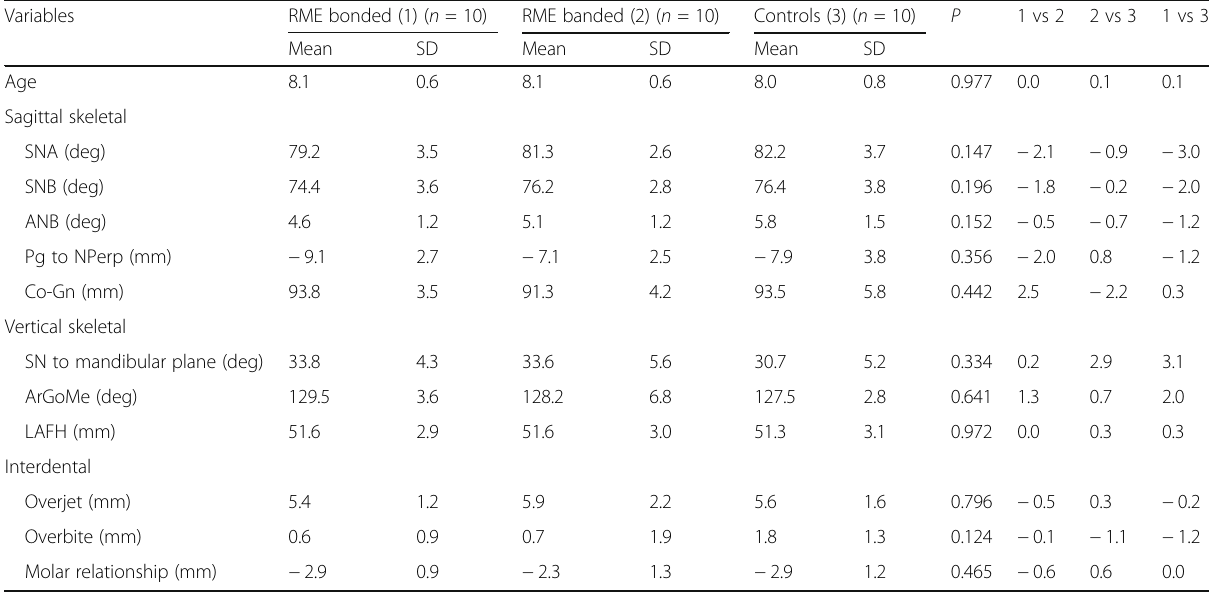
Table 1 Descriptive statistics and statistical comparisons of starting forms (ANOVA with Tukey ’ s post hoc tests)